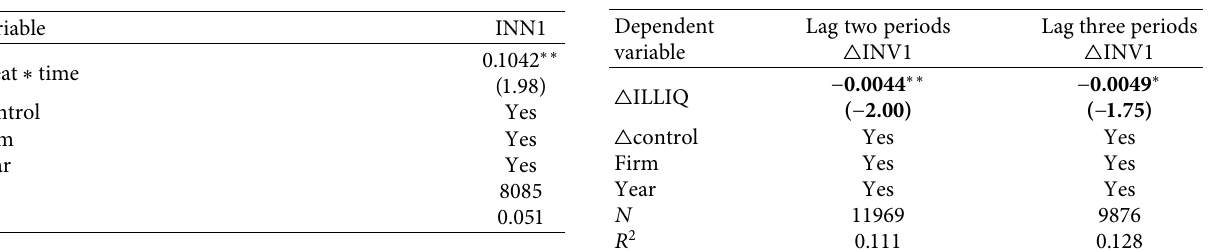
Table 6: Entropy balance and DID final result. Table 7: Time series stationarity test.